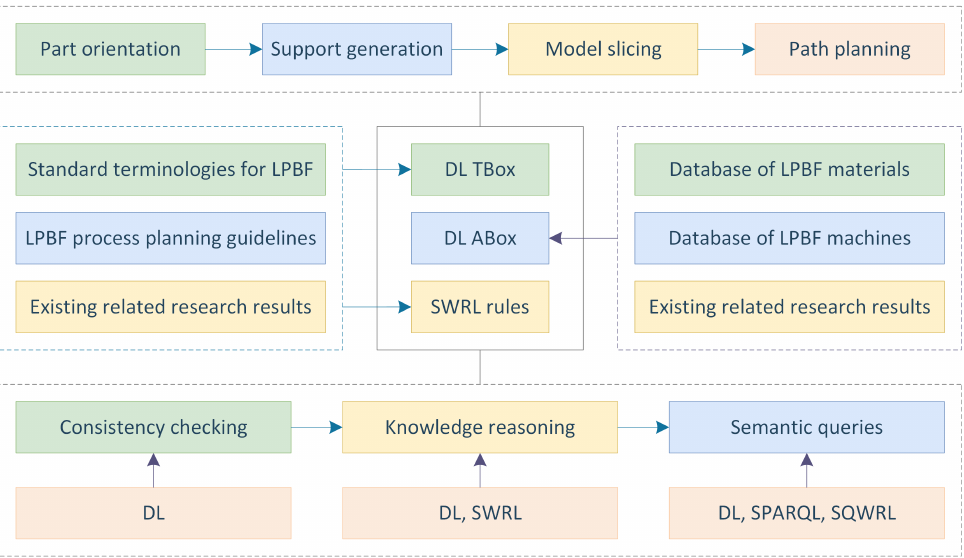
Figure 2. Schematic diagram of the development process of the DL-based